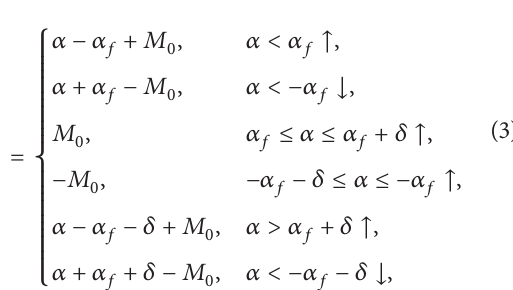
coefficients per control surface deflection 𝛽 , and 𝑘 𝑎 (𝛼) and 𝑘 ℎ are the pitch and plunge stiffness coefficients,